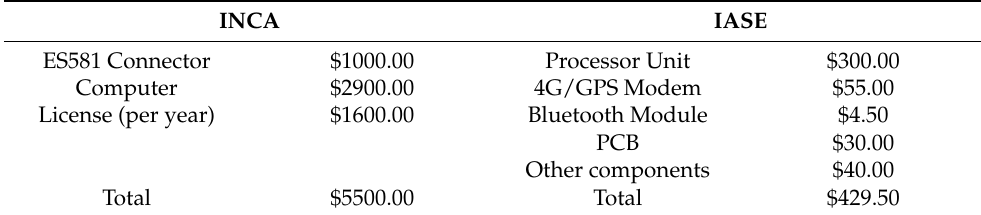
Table 3. Cost comparison between INCA and